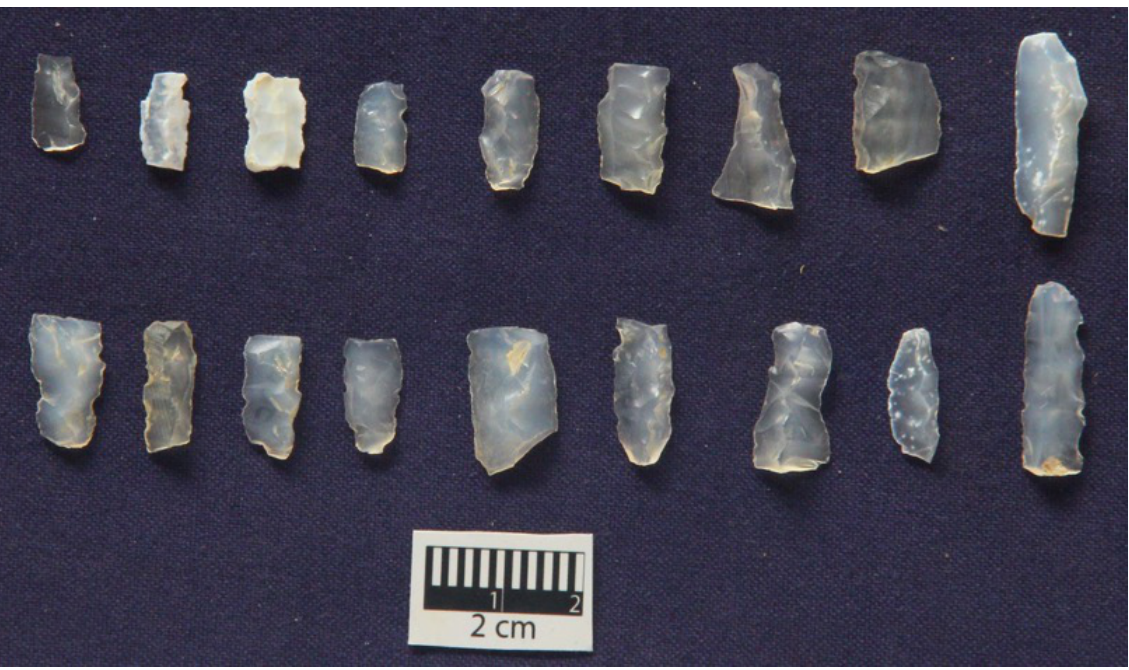
Figure 4: Crested ridge blades from Juna Khatiya (P.C. Department of Archaeology, University of Kerala) Blade flakes: Eight heavily utilised blade flakes have been identified from the assemblage (Table 2).